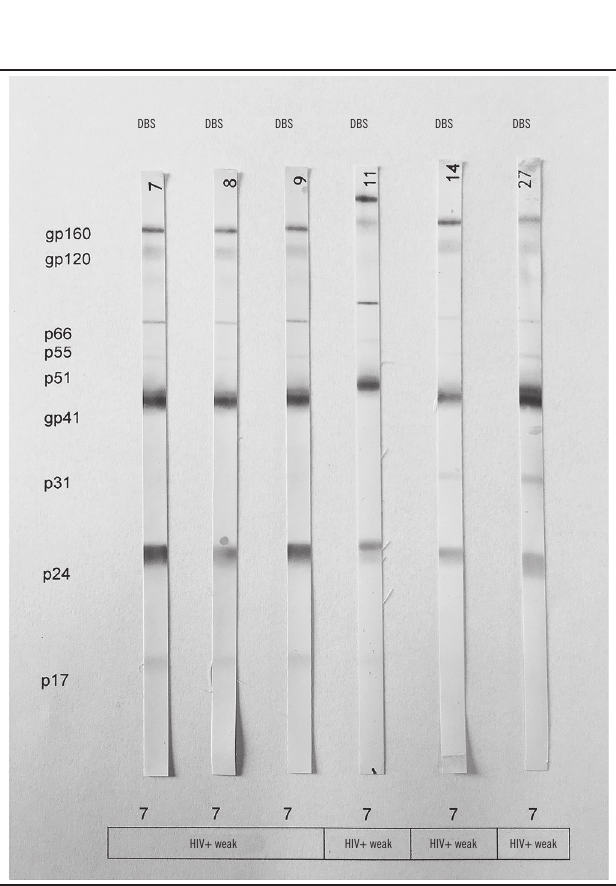
figurE 2 − Results of evaluation of intra- and inter-assay precision of an HIV-positive DBS sample (weakly reactive) DBS: dried blood spot; +: positive.